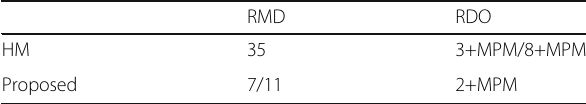
Table 4 Number of candidate modes of the proposed algorithm and original HM